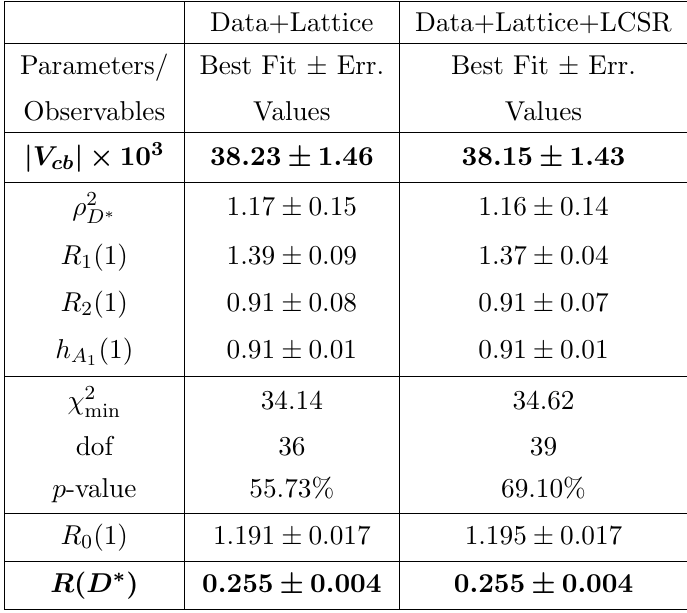
Table 4 . Fit results with CLN for B ! D (cid:3) ‘(cid:23) ‘ , combined with constraint from eq. (2.1).